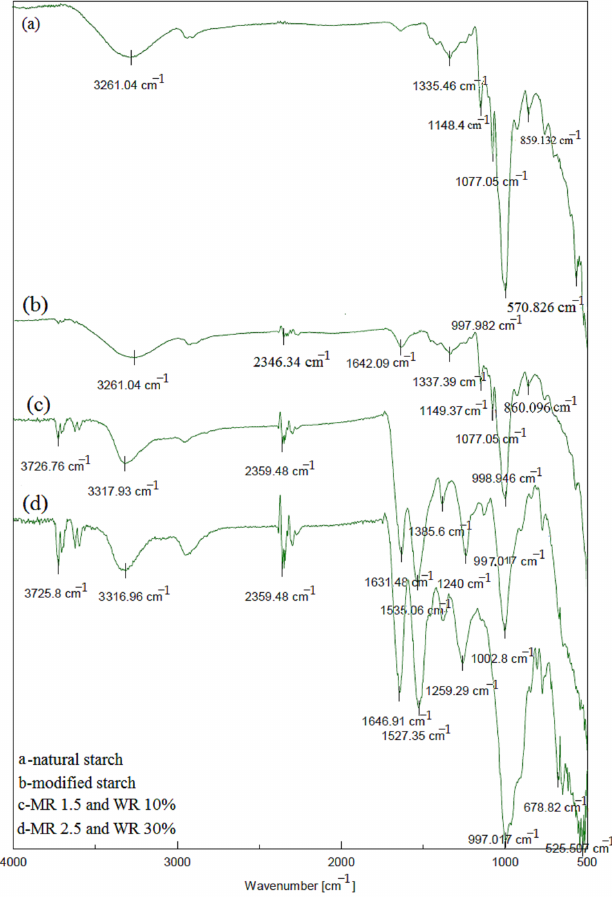
Figure 1. FT-IR spectra of natural starch ( a ), modified starch ( b ), UF-MS (MR of 1.5 and WR of 10% Figure 1. ( a ) FT-IR spectra of natural starch, ( b ) modified starch, ( c ) UF-MS (MR of 1.5 and WR of ( c )) and UF-Ma) (MR of 2.5 and WR of 30%, ( d )). 10%) and ( d ) UF-Ma (MR of 2.5 and WR of